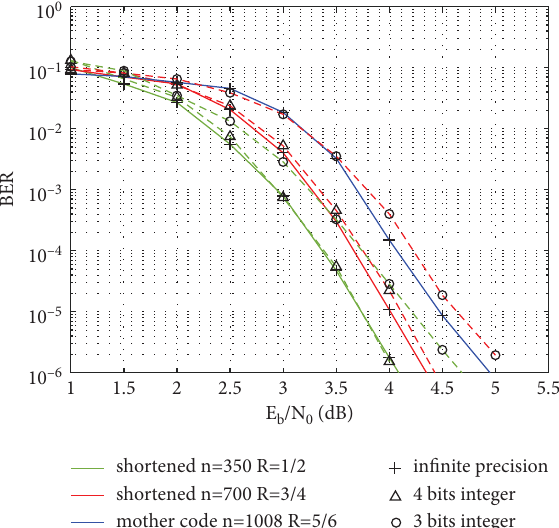
Figure 14: BER performance of MSA decoding for shortening LDPC codes. Te solid lines represent infnite precision and the dash lines mean integer